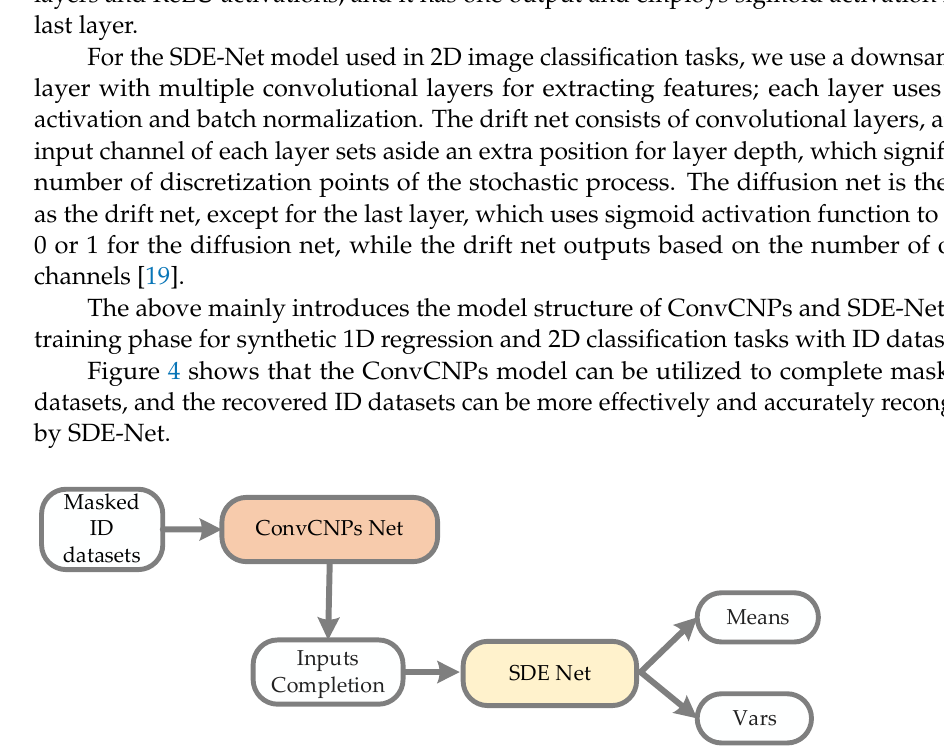
Figure 4. The process architecture of the ConvCNPs – SDE model for masked ID datasets. Con- vCNPs-Net is used to complete the masked ID data, and then the completed data is processed with SDE-Net to produce Means and